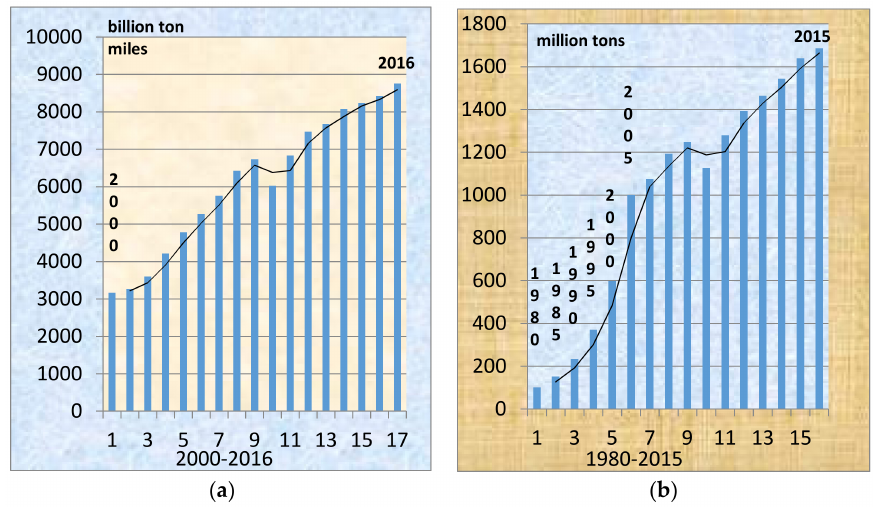
Figure 3. World seaborne trade in containers: ( a ) in billion ton-miles, 2000–2016; and ( b ) in million tons loaded (1980–2015; selected years). Source: Author and excel on numbers from UNCTAD (2016). Trend line: a 2 year moving average. 2015 estimated; 2016 forecast.